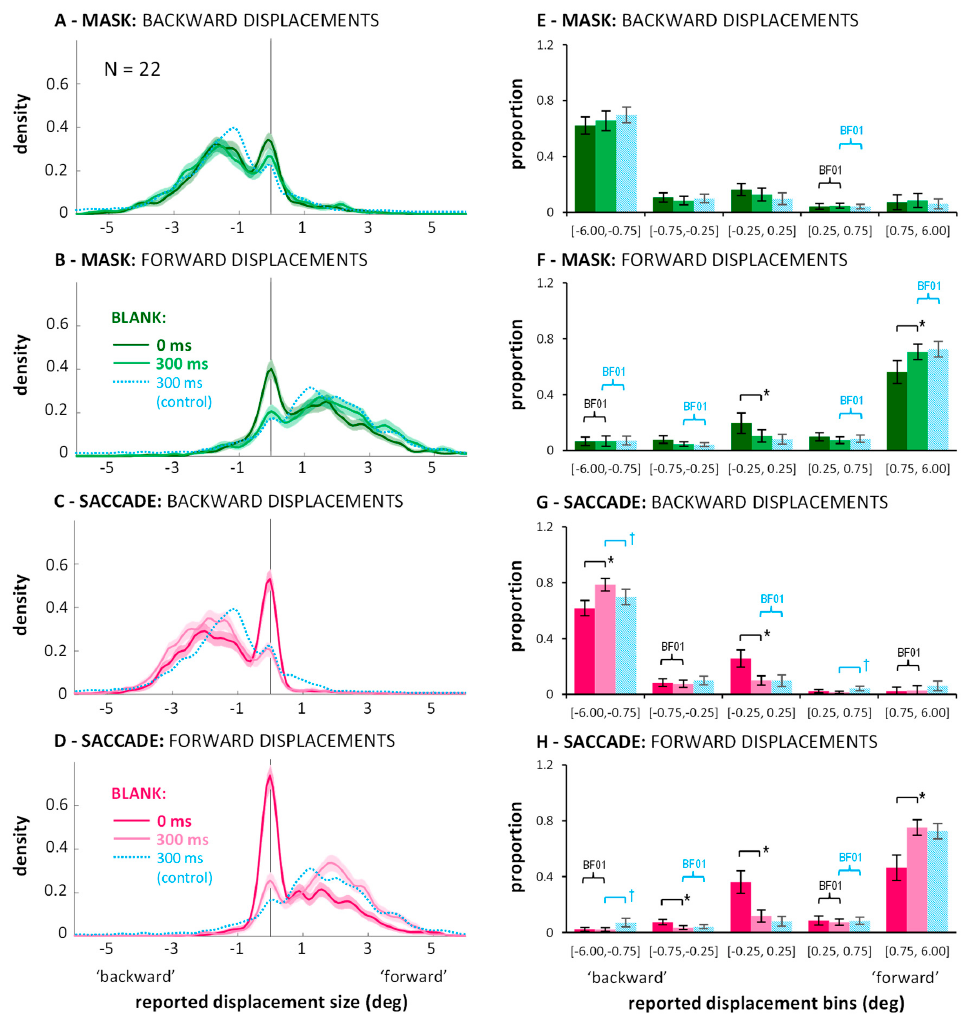
Figure 5. Distribution of responses in the saccade (magenta) and mask (green) conditions of Experiment 2, with (light colors) or without (saturated colors) a 300 ms blank: Kernel density functions (panels ( A – D ), and proportion of responses falling into the specified bins (panels ( E–H ). Conventions as in Figure 3. Thin blue lines and striped blue bars represent data from a 300 ms blank during fixation condition without mask (Appendix B). Brackets marked with * illustrate significant di ff erences in post-hoc within-subjects paired t -tests ( p < 0.0025). Brackets marked with † illustrate significant di ff erences in post-hoc between-subjects t -tests ( p < 0.05). Curly braces marked with BF01 illustrate Bayes factors in favor of H0, BF 01 >